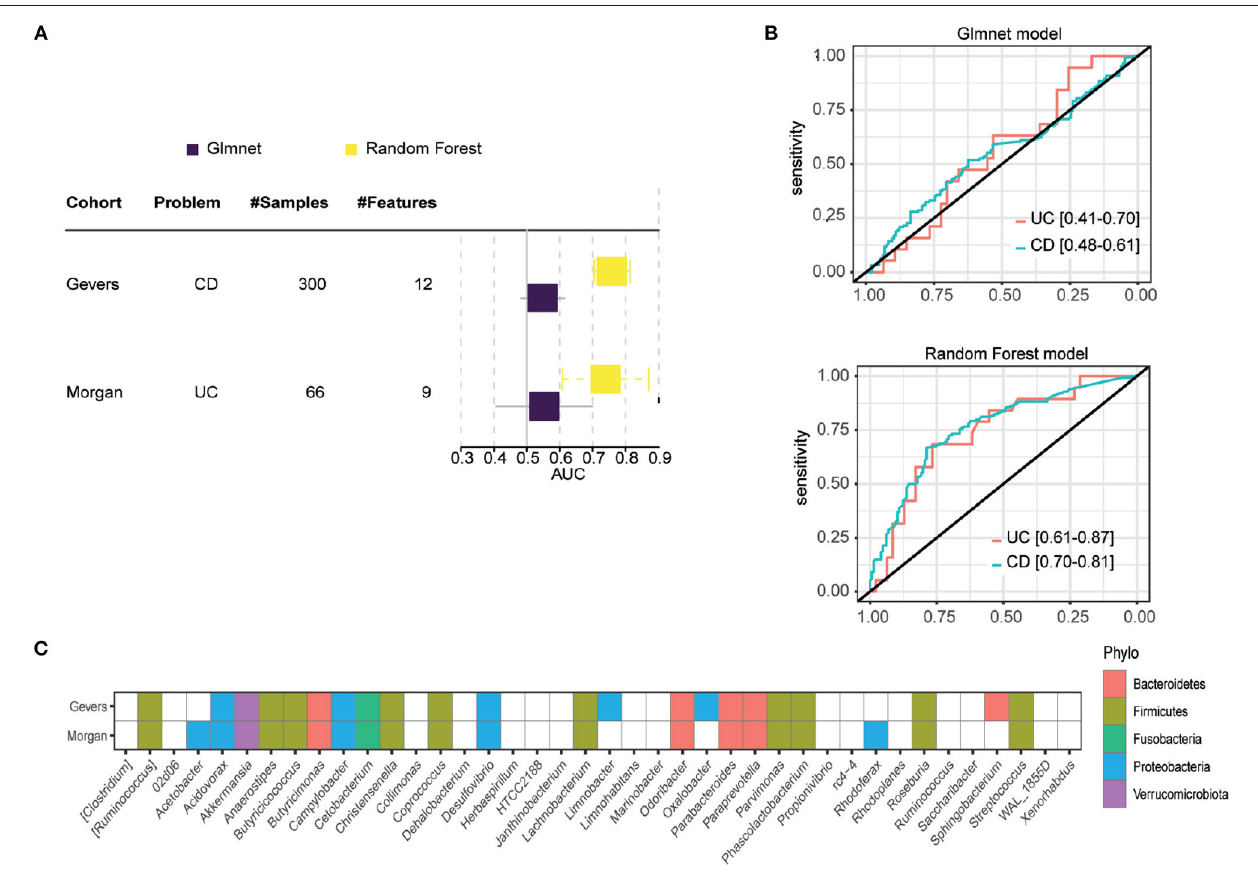
FIGURE 2 | External validation results. (A) Results obtained in each of the external validation datasets, measured in AUC. (B) ROC curve of the RF model in the two external validation datasets. (C) Genes available in each external validation cohort, with which the models were re-trained.